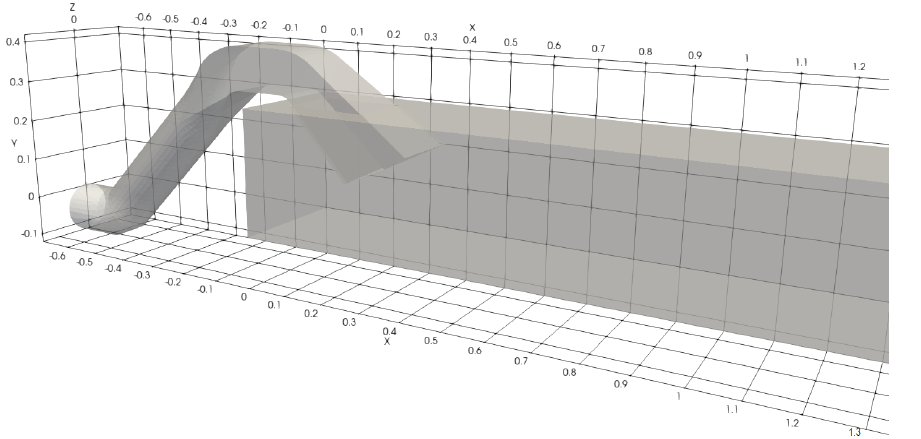
Figure 3. Front part of the computational domain.